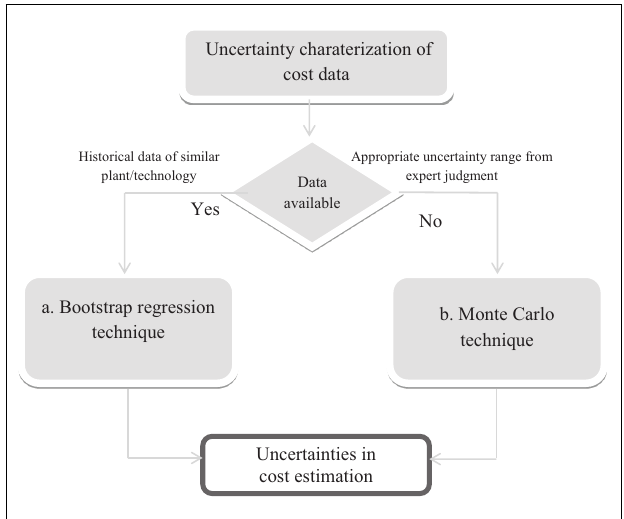
FIGURE 2 |The simplified framework of uncertainty analysis for early-stage cost estimation .